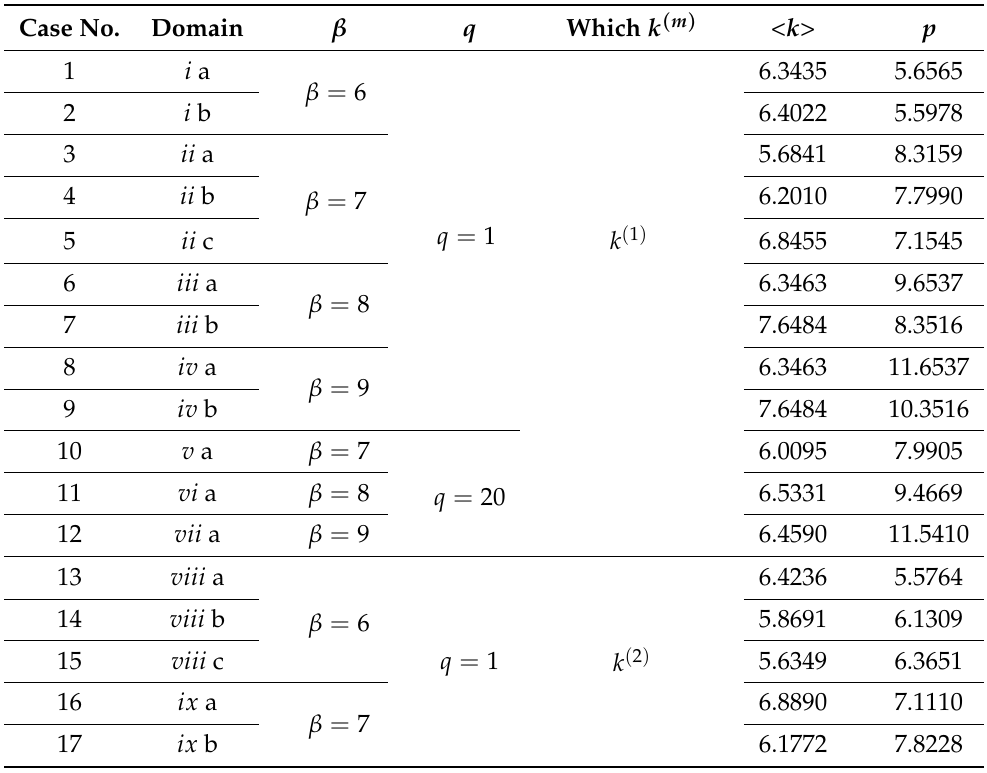
Figure 8. Subpopulation size vs space for different coupling strength q , different values of β and different random carrying capacities. Table 1. Average carrying capacity < k > and quantity p (see relation (18)) calculated for the extinction domains shown in Figure